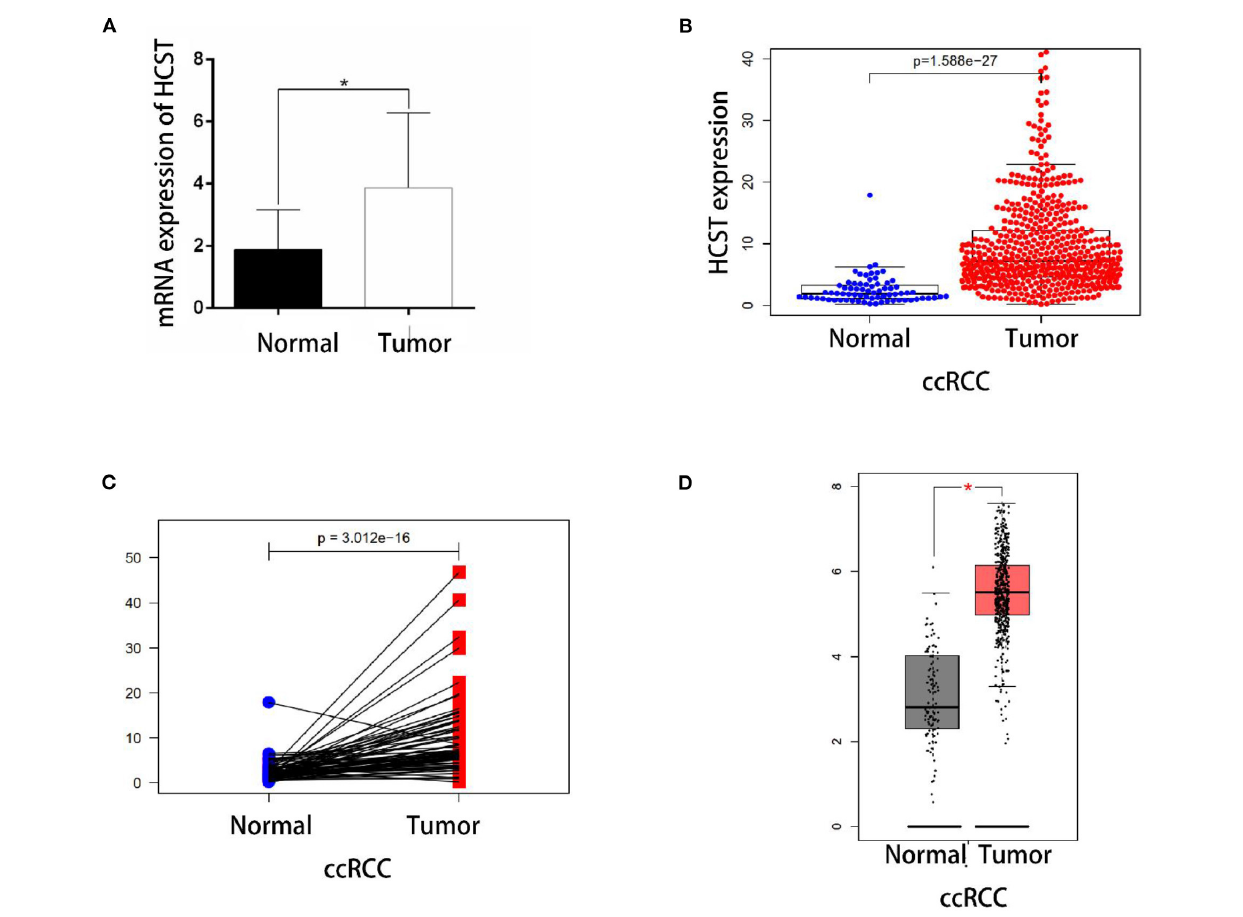
FIGURE 5 | Experimental validation. (A) Detection of HCST mRNA expression levels in 10 cases of renal carcinoma and para-cancer tissue by qRT-PCR. The glyceraldehyde 3-phosphate dehydrogenase gene was used as an internal control. HCST expression in cancer cells is clearly higher than normal kidney cells. (B) Statistical analyses of the mRNA expression levels of the HCST according to the information of normal and ccRCC tissues from R version 4.0.2 software matching TCGA data. (C) Statistical analyses of the mRNA expression levels of the HCST according to cancer and para-cancerous tissue from the same ccRCC patient from R version 4.0.2 software matching TCGA data. (D) Statistical analyses of the mRNA expression levels of the HCST according to the information of normal and ccRCC tissues from GEPIA 2 matching TCGA and GTEx data. * p < 0.05.